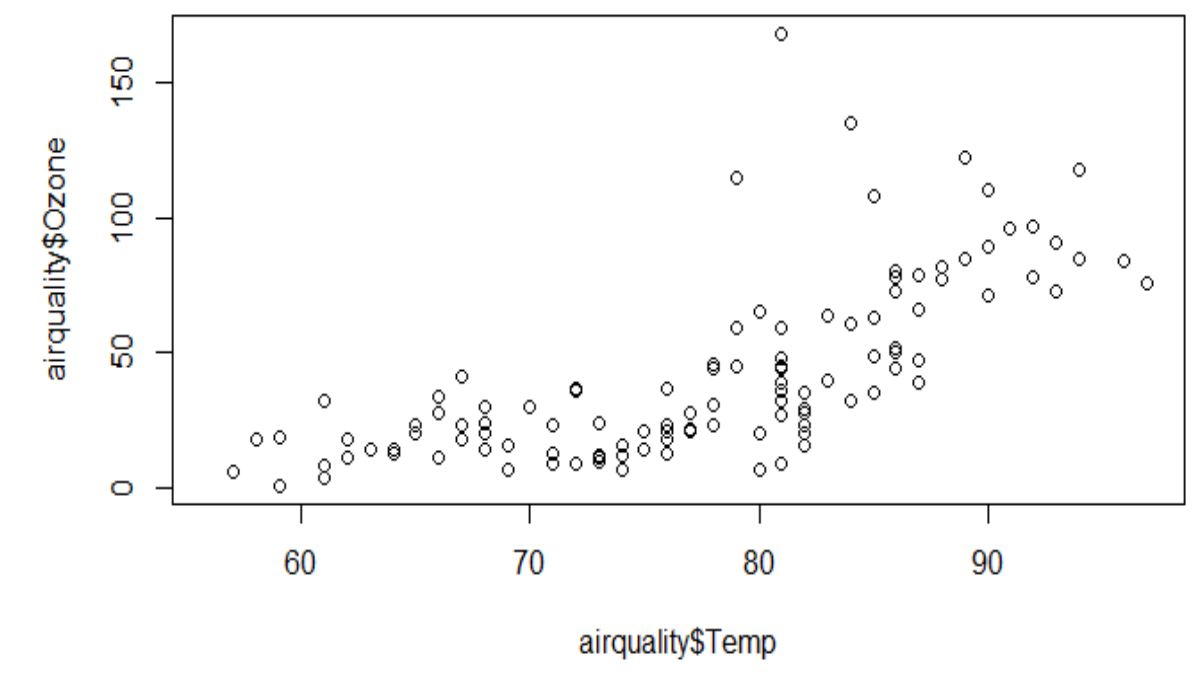
Figure 4. Outliers in a scatterplot. (a) Point Anomaly